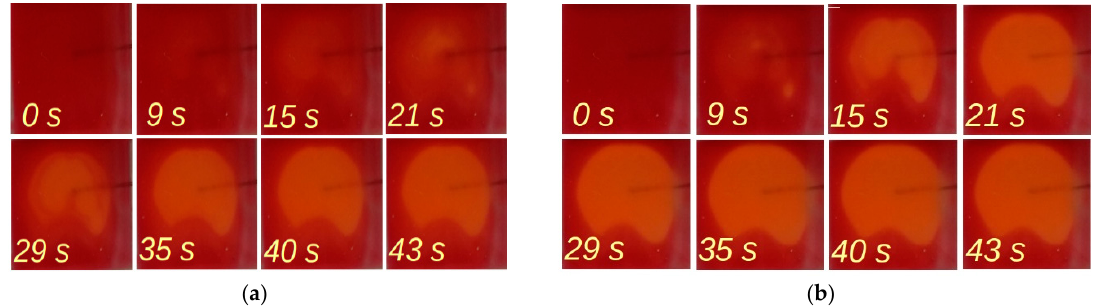
Figure 9. Visualization of the heating of microstructures using a thermochromic coating: ( a ) 100 mA; ( b ) 140 mA.